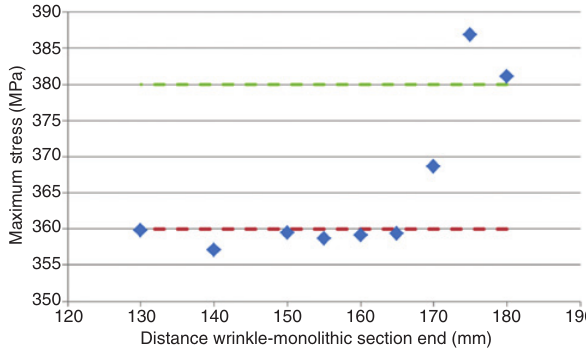
Figure 4 Influence of distance wrinkle-monolithic section end in maximum